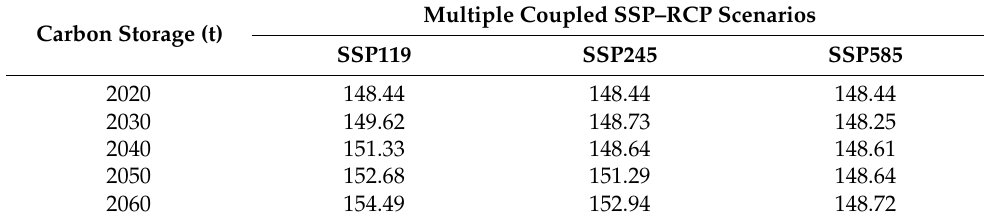
Table 3. Carbon storage under the future scenarios at different times.